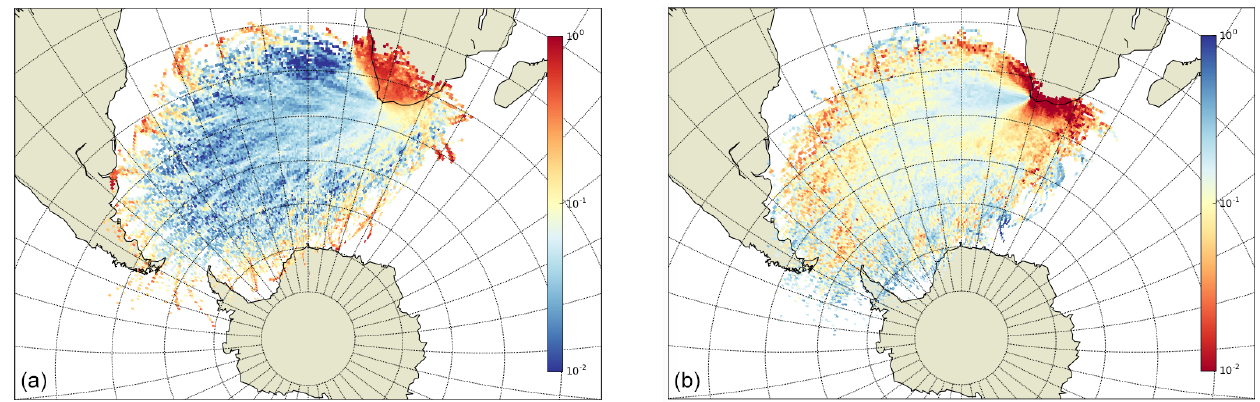
Figure 4. Distribution map for the (a) 90th percentile highest 222 Rn concentrations and the (b) 10th percentile lowest 222 Rn concentra- tions measured at Cape Point. Values are the dimensionless prevalence of air parcels of a given concentration percentile ranging from 0 to 1. This means that a homogeneous distribution of source and sink regions would lead to a plot with values of 0.1 everywhere. Deviations from this value indicate source and sink regions. See also the description in Sect. 2.4.